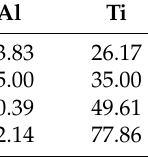
Table 5. Chemical composition (at %) of different points, as marked in Figure 7d. Points